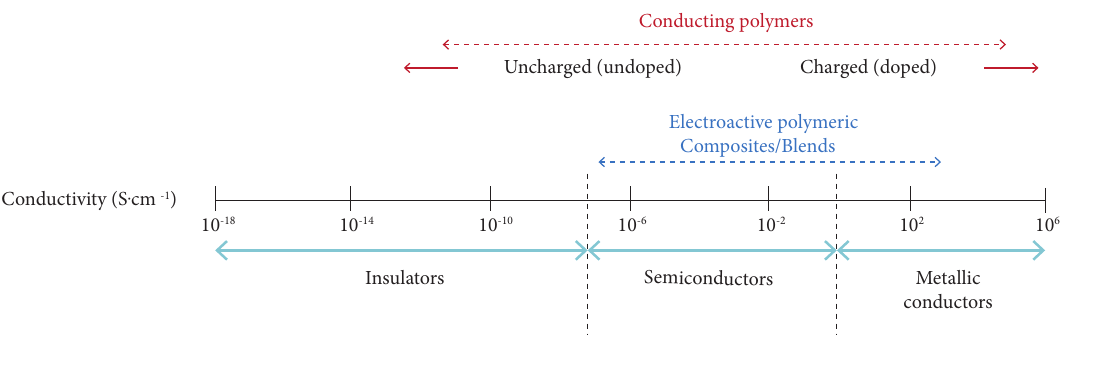
Figure 5. Conductivity range of conducting polymers and conductive polymer composites (Campbell 2010; Ruschau et al.